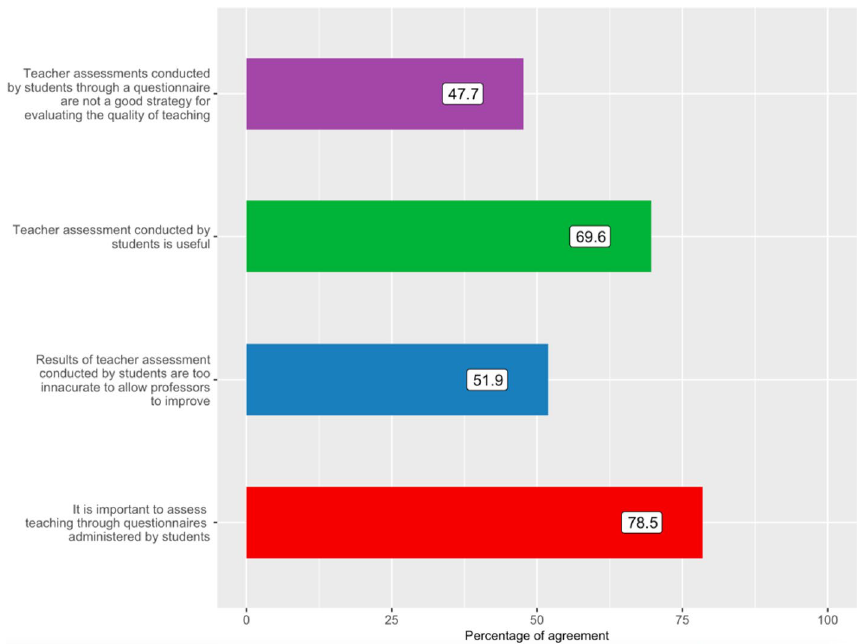
Fig. 3 Percentage of respond‑ ents who say they "somewhat agree or strongly agree" with regard to the appreciation of teaching by